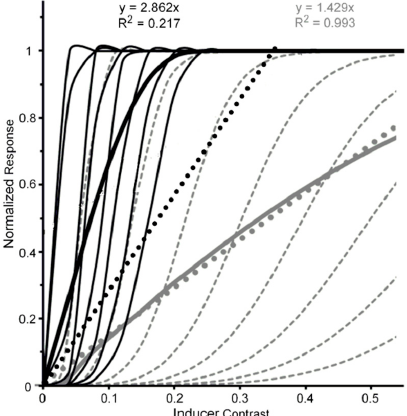
Figure 4. Black lines and symbols: Hypothetical normalized CRFs for eight high-level extrastriate neurons (thin black continuous lines), the resulting normalized neuron-ensemble CRF (thick black continuous line), and the best linear fit (black dotted line) to the neuron-ensemble CRF when tilt-inducing surround is visible. Grey lines and symbols: Hypothetical normalized CRFs for the same eight high-level extrastriate neurons (thin grey dashed lines), the resulting normalized neuron-ensemble CRF (thick grey continuous line), and the best linear fit (grey dotted line) to the neuron-ensemble CRF when tilt-inducing surround is b-r suppressed.